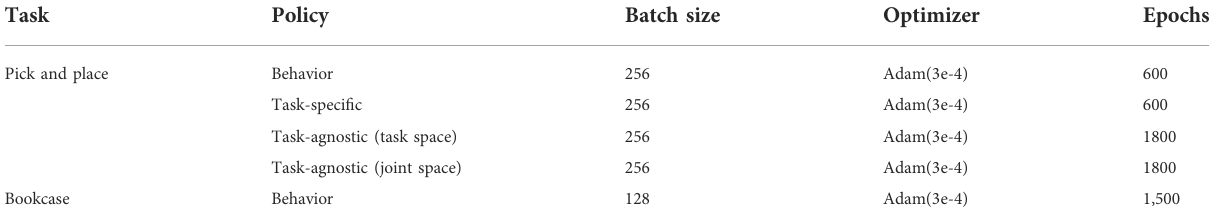
TABLE 4 Training